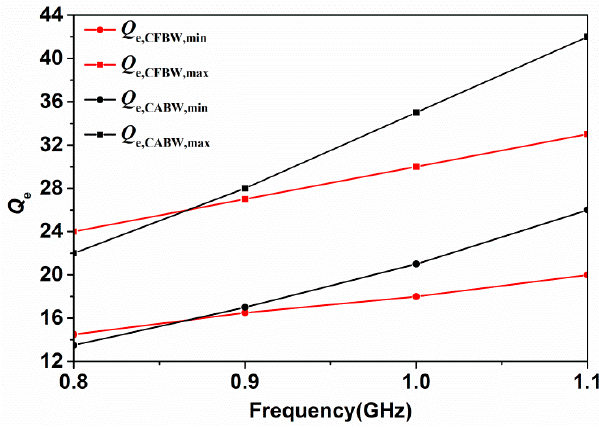
Figure 4. Desired Q e for 74 MHz CABW and 8.5% CFBW.